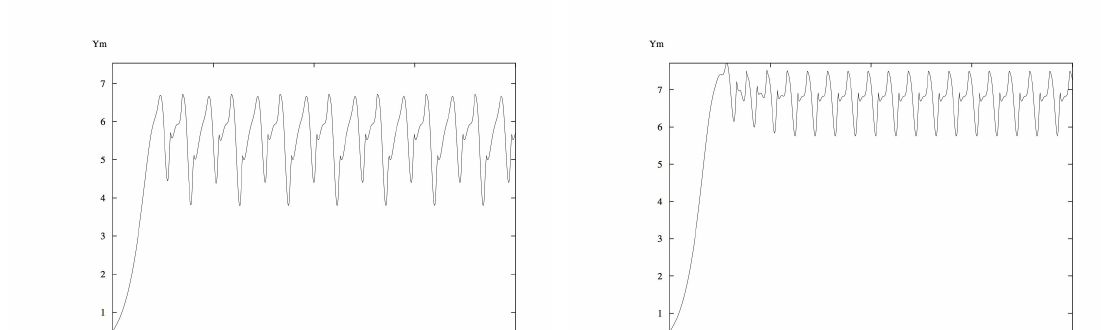
Figure 7. Phase plane diagrams for ( Y m , Y , Z ) for varying k mp .